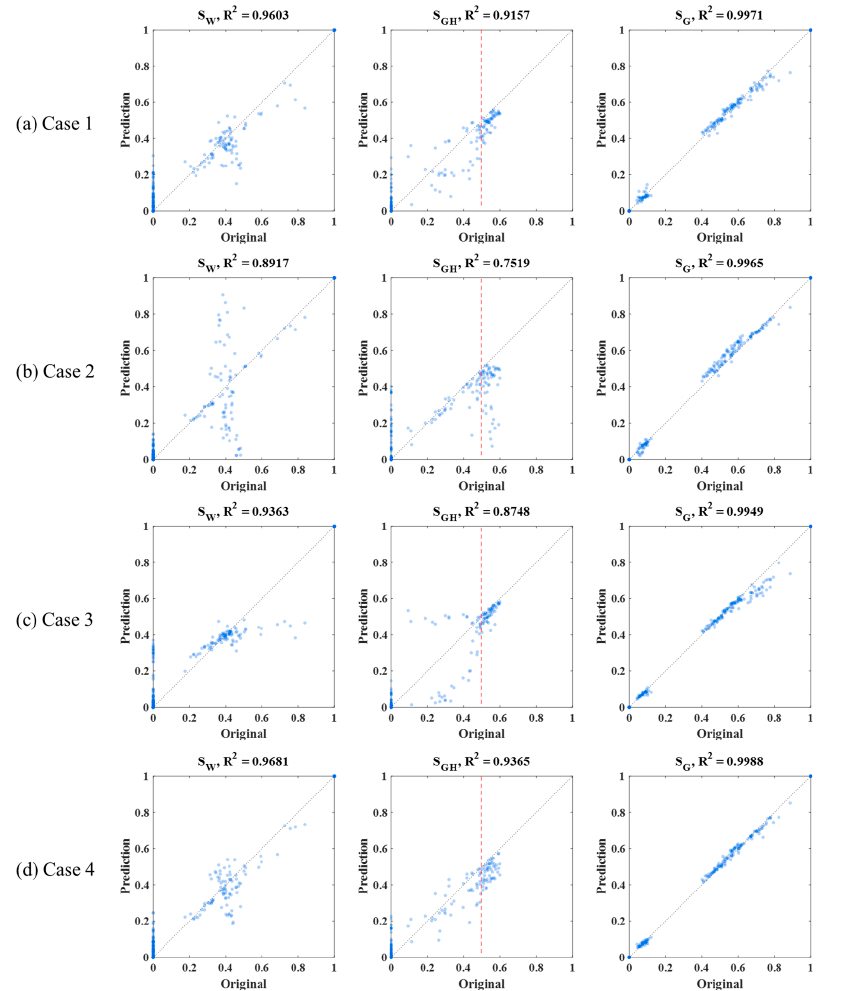
Figure 13. Universal test set results of Cases 1–4 corresponding to ( a )–( d ) in order. ( a ) Case 1 of the total eight GH samples; ( b ) Case 2 of the three low S GH samples; ( c ) Case 3 of the five high S GH samples; ( d ) Case 4 composed of the two low S GH and the two high S GH samples; each column represents each saturation, water, gas hydrate, and gas with coefficient of determination; the X and Y axes indicate the given original data and the predicted value by random forest; the red dotted line is drawn at 50% of S GH to clarify given data trend.